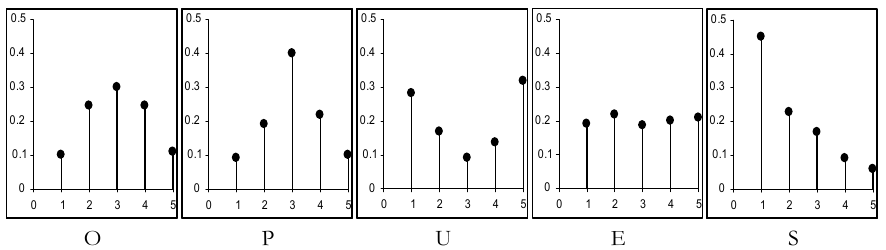
Figure 1 – The frequency distributions associated to the five different types of